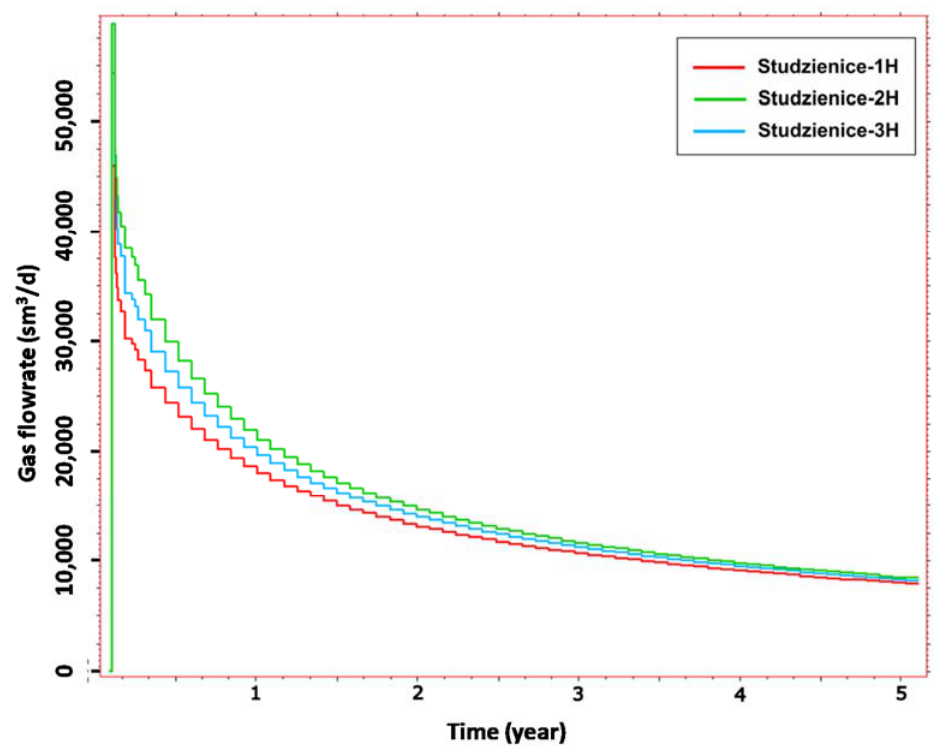
Figure 8. The comparison of the changes in methane production rates in the particular wells.